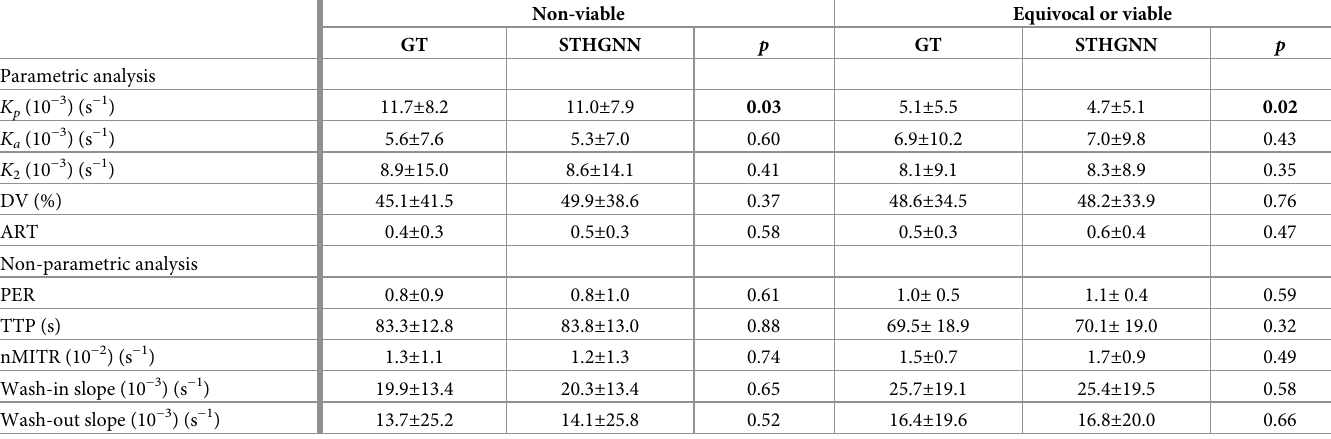
Table 3. Parametric and non-parametric perfusion values extracted from the ground-truth (GT) and proposed predictive model (STDGNN). Analysis of differences was performed by paired Wilcoxon tests ( p < 0.05). Bold values indicate significant